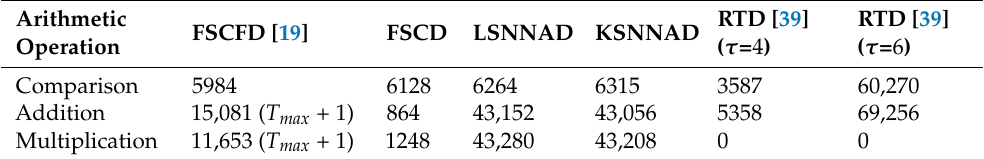
Table 4. Total number of arithmetic operations for different decoding